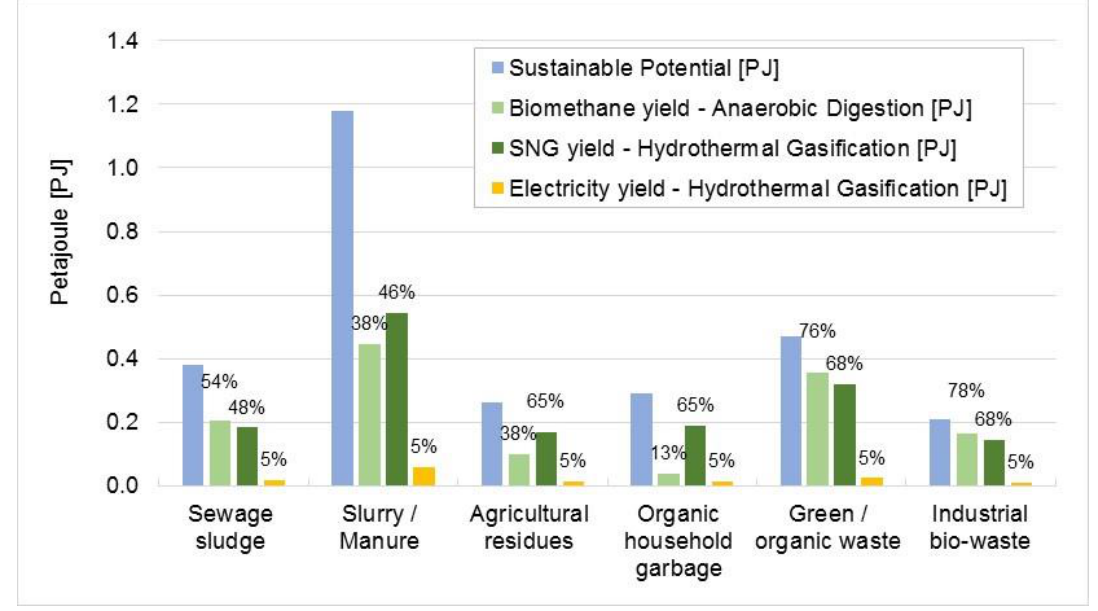
Figure 3. Conversion efficiency of anaerobic digestion and hydrothermal gasification of various non-woody biomasses.